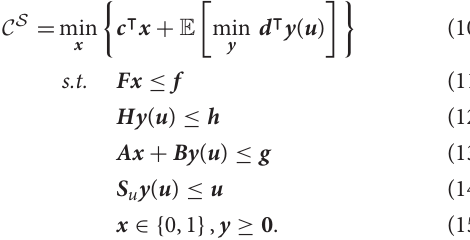
FIGURE 2 | Probability distributions fit to histogram of forecast errors in Germany in